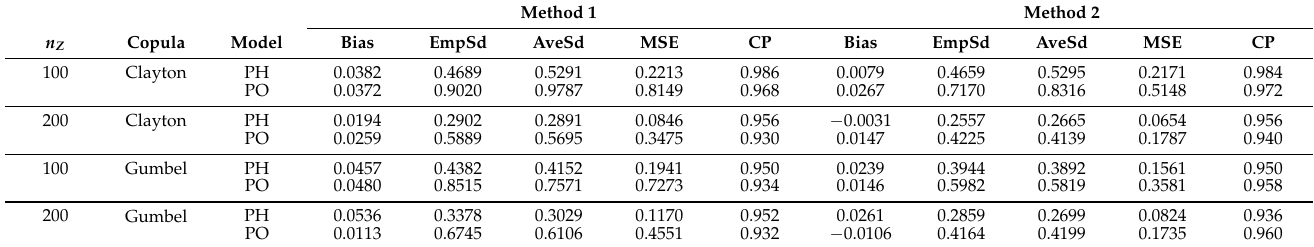
Table 5. The estimators of θ under Case 1 with τ = − 0.05 when the variable of interest is X.